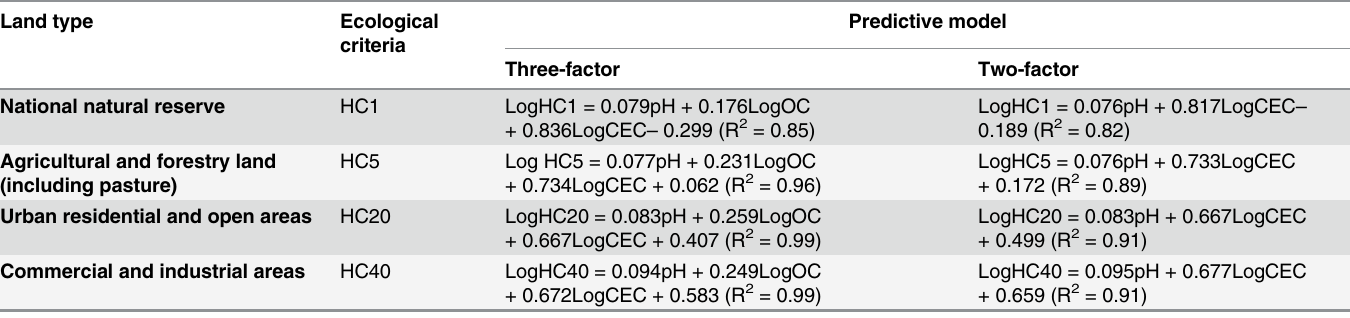
Table 3. Predictive models of Cu ecological criteria in soils for different land